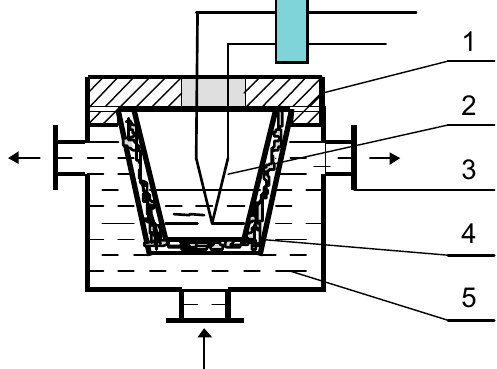
Figure 1: Scheme of the reactor used to study the copolymerization process: 1-lid; 2-thermocouple; 3 – orifice for the tempered fluid; 4- vessel for the investigated resin; 5 – circulating